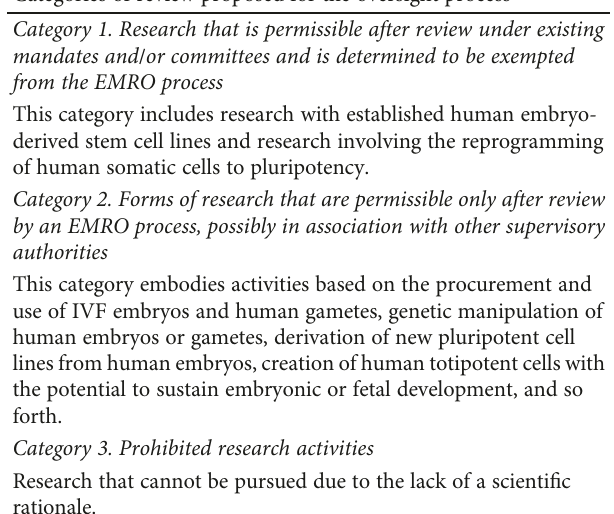
Table 3: Review categories recommended to improve the supervision